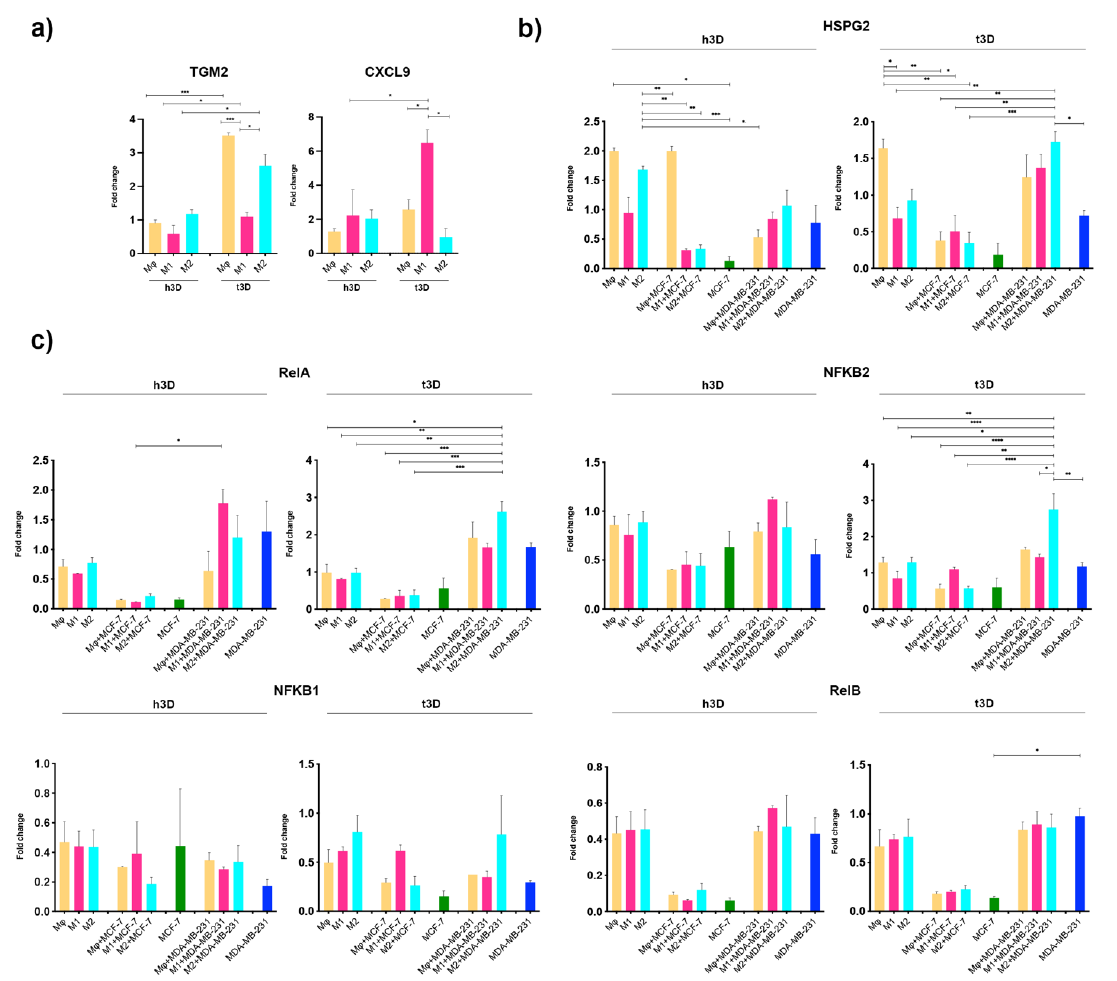
Figure 6. Macrophage genes expression in h3D and t3D matrix. ( a) M2-markers and for ( b) HSPG2, ( c ) canonical and non-canonical NF- κ B pathway by qRT-PCR. One-way ANOVA and Tukey correction were used to evaluate the differences between means; * p < 0.033, ** p < 0.002, *** p < 0.0002, **** p < 0.0001. n = 3 for each experimental group.